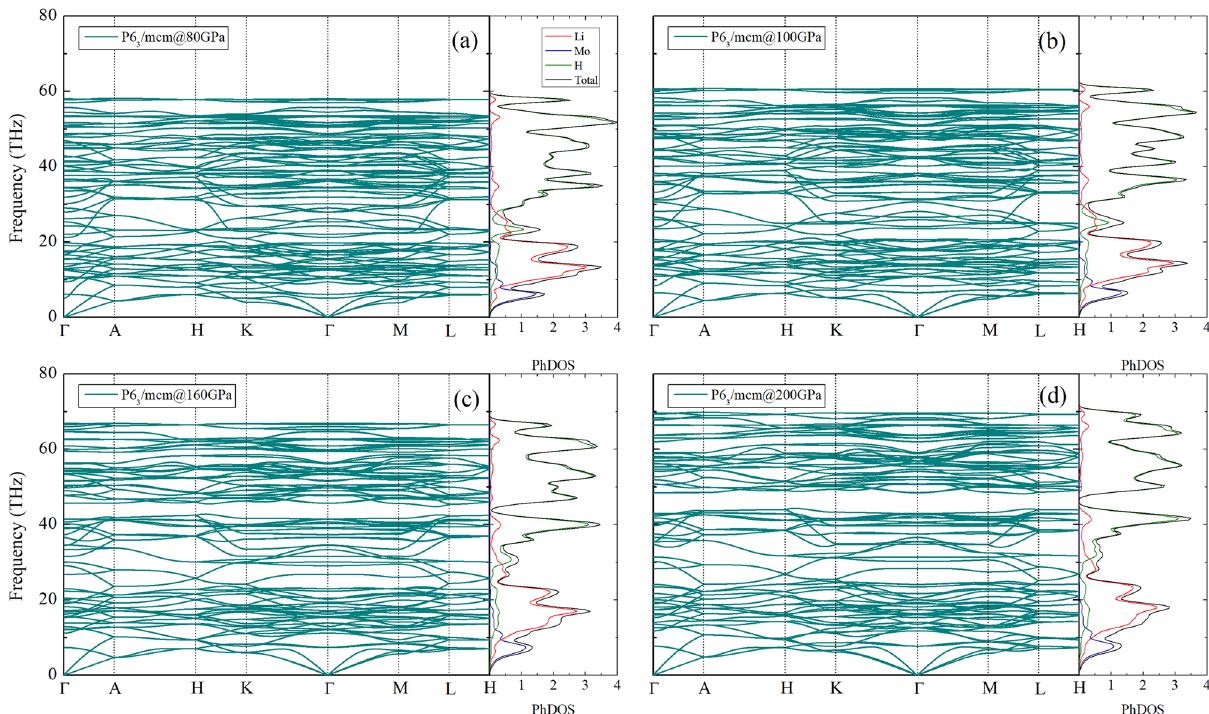
Figure 4. The phonon dispersion of Li 5 MoH 11 (a) P6 3 /mcm at 80 GPa, (b) P6 3 /mcm at 100 GPa, (c) P6 3 /mcm at 160 GPa, and (d) P6